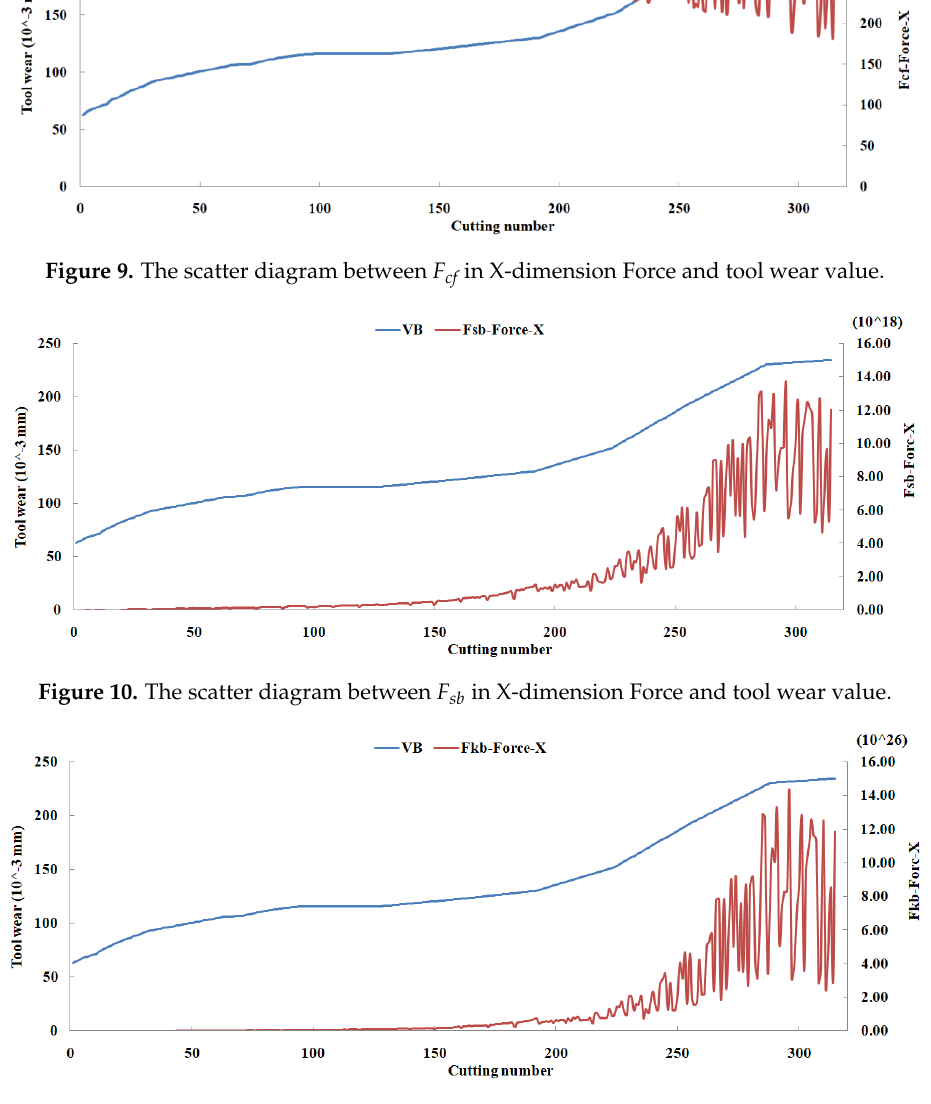
Figure 11. The scatter diagram between F kb in X-dimension Force and tool wear value.